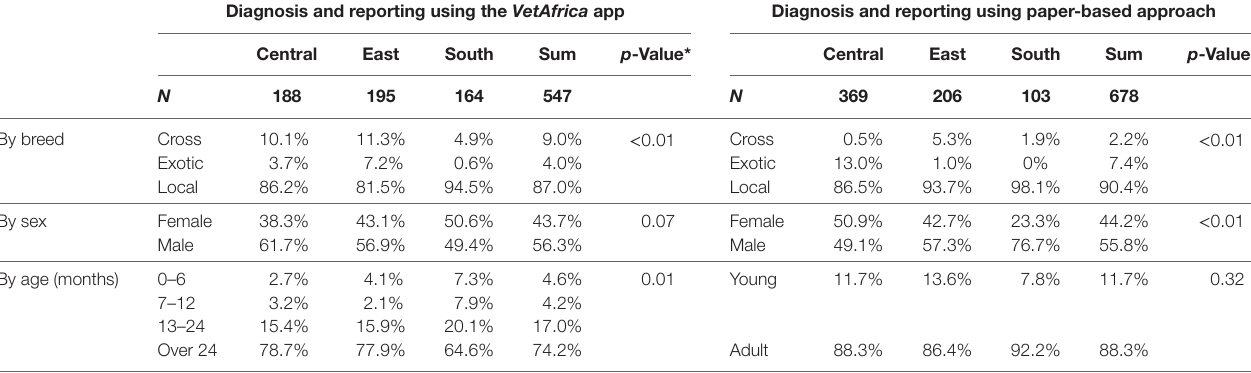
TaBle 1 | Breakdown of cases in cattle refcorded using VetAfrica ( N = 547) and those using traditional paper-based reporting ( N = 678) by region and in terms of proportions across key variables within each region. Diagnosis and reporting using the VetAfrica app Diagnosis and reporting using paper-based